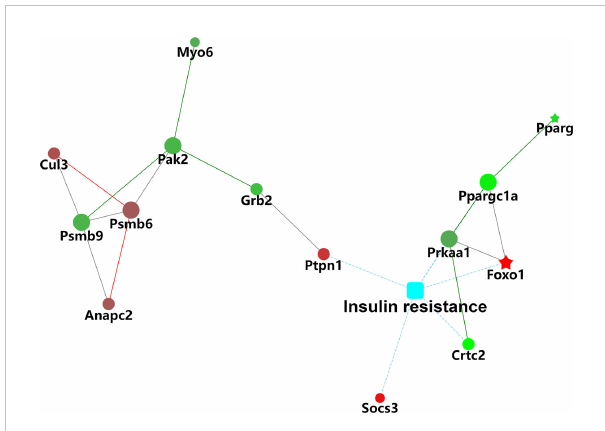
FIGURE 10 Protein – protein interaction (PPI) network analysis of differentially insulin resistance-associated